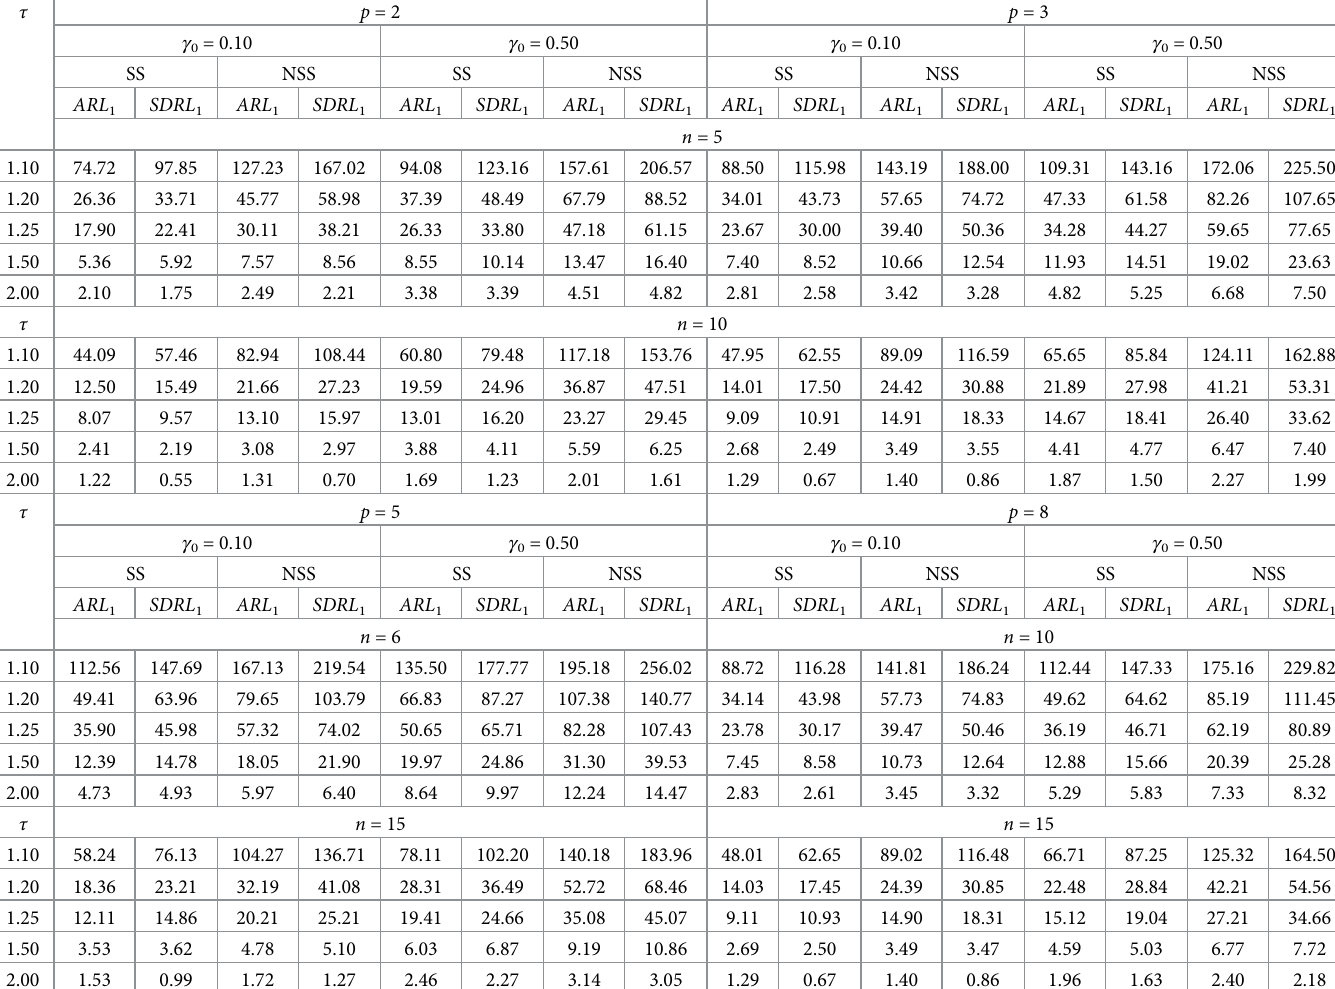
Table 5. A comparison of the ARL1 and SDRL1 of the multivariate SS and NSS charts for p 2 {2,3,5,8}, n 2 {5,6,10,15}, τ 2 {1.10,1.20,1.25,1.50,2.00} and γ 0 2